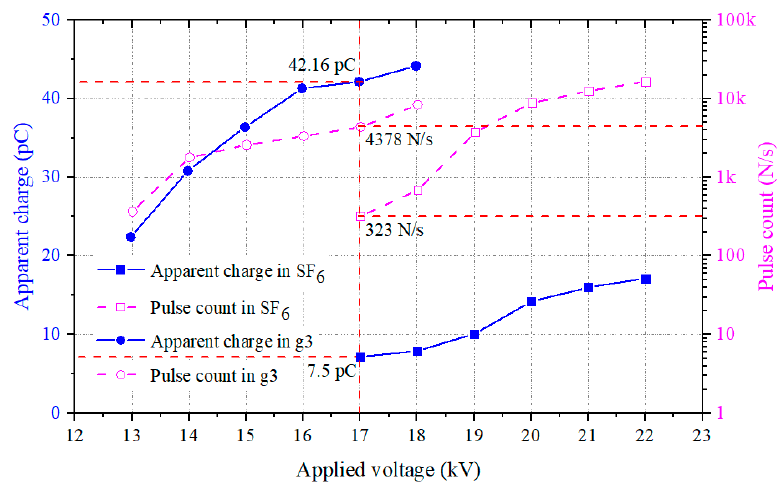
Figure 6. Average apparent charge and pulse count in SF 6 and g3 in the POC.